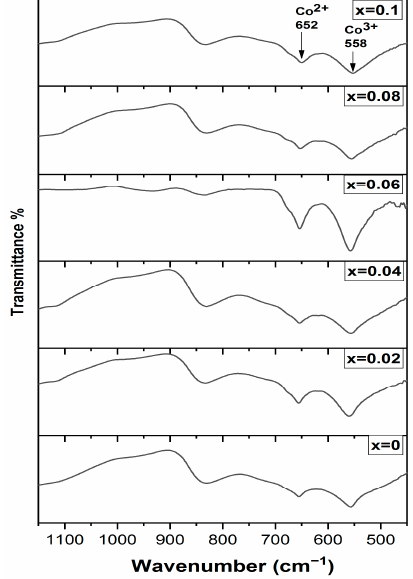
Figure 2. FTIR spectra of Cr doped Co 3 O 4 thin films.